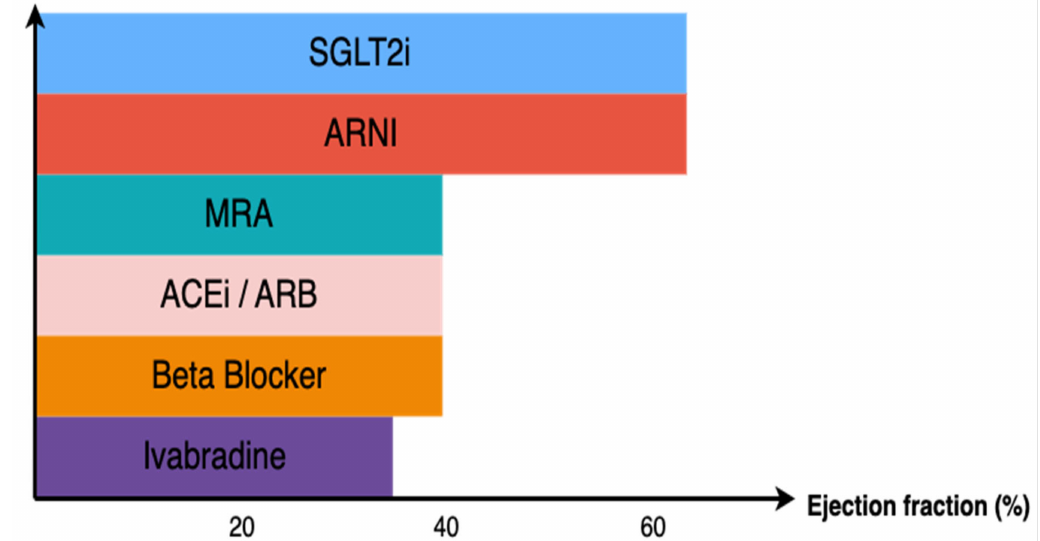
Figure 1. Foundational heart failure therapy consisting of Sodium Glucose Cotransporter 2 Inhibitors (SGLT2i), mineralocorticoid receptor antagonists (MRA), angiotensin-converting enzyme inhibitors (ACEi), angiotensin receptor blockers (ARB), angiotensin receptor-neprilysin inhibitors (ARNI), beta blockers and ivabradine and their respective ejection fraction